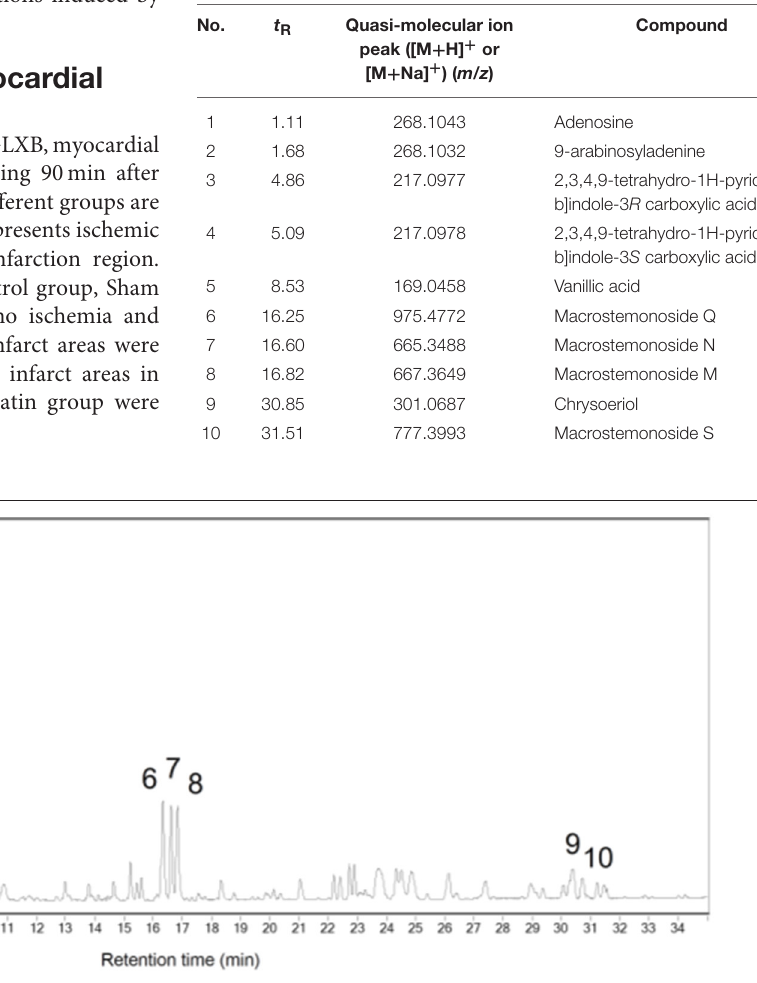
TABLE 2 | Major compounds in the total extract of GLXB.